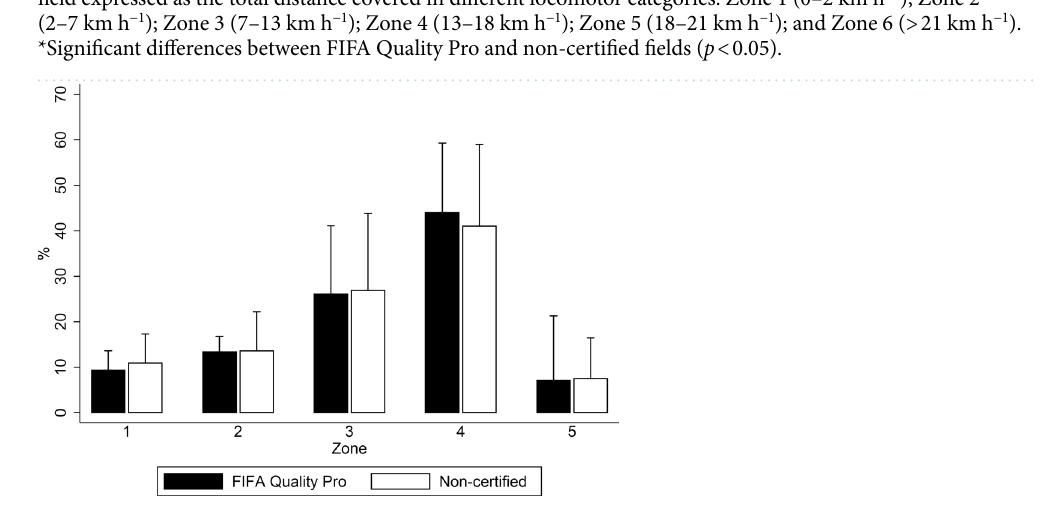
Figure 2. Distribution of heart rate expressed as the percentage of game time taken in the different ranges of HR MAX during a simulated game test (BEAST 90 ) in a FIFA Quality Pro (Black) and a non-certified (White) artificial turf football